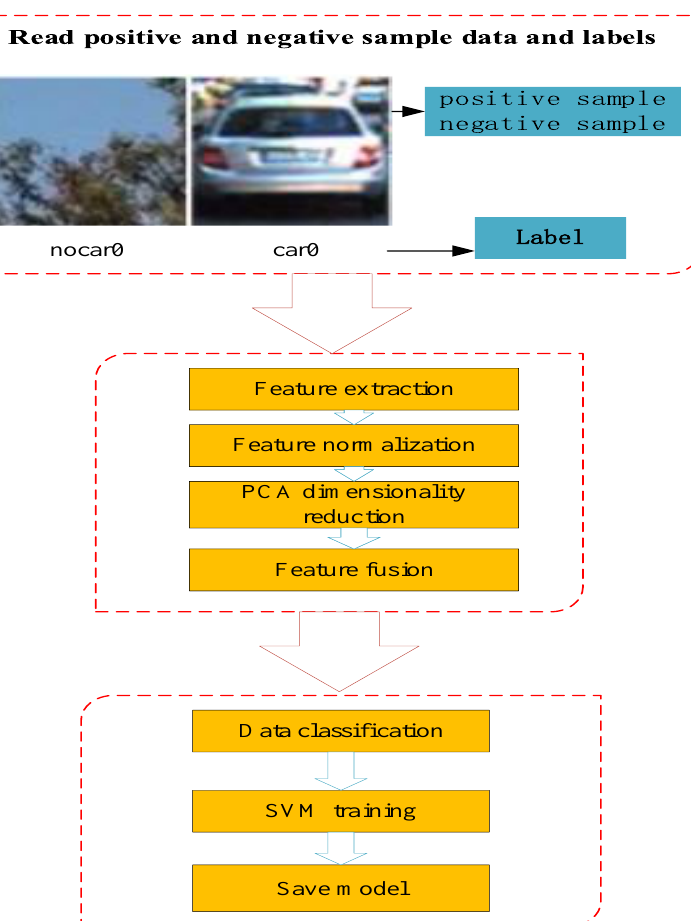
Figure 10. Support vector machine (SVM) training process.